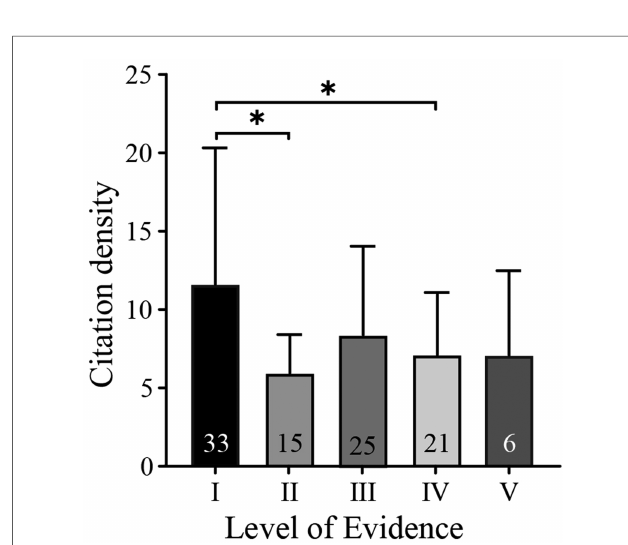
FIGURE 5 Mean citation density based on the level of evidence. Note: The number at the bottom of the column represents the number of articles. There was a signi fi cant difference between levels I and II and levels I and IV, * means p <0.05.